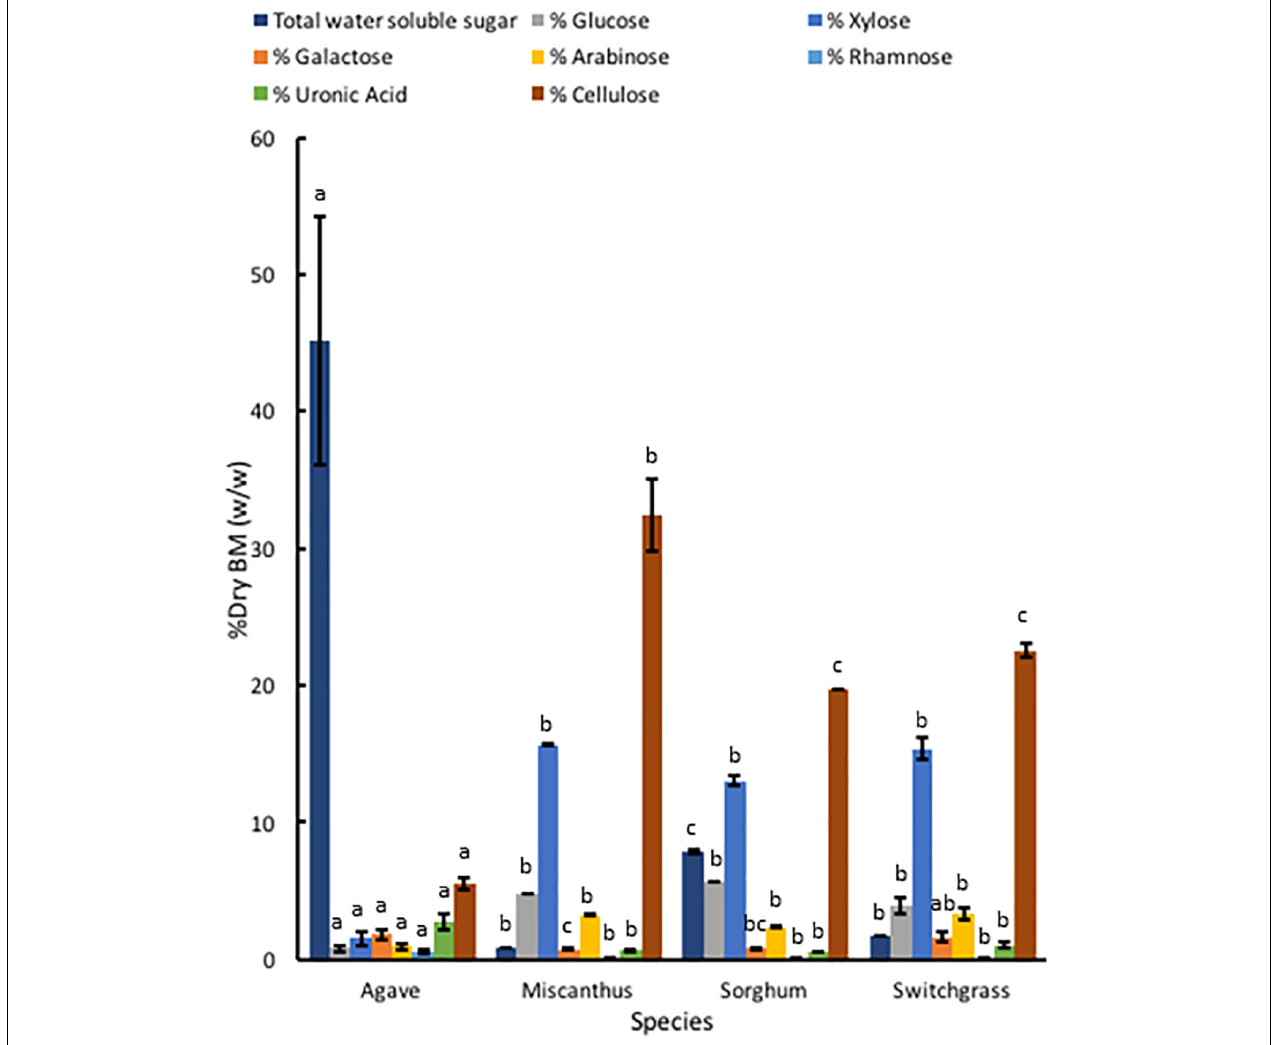
FIGURE 6 | Polysaccharide composition of dry biomass (%) from TFA hydrolysis and phenol-sulfuric acid hydrolysis of EFBM showing mean percent total water-soluble carbohydrates, glucose, xylose, galactose, arabinose, rhamnose, uronic acid, and cellulose for A. americana , miscanthus, sorghum, and switchgrass ( n = 16 for A. americana and n = 3 for grasses). Lowercase letters above bars indicate significant differences between species ( p < 0.05) from one-way ANOVA and Tukey’s HSD test of each soluble